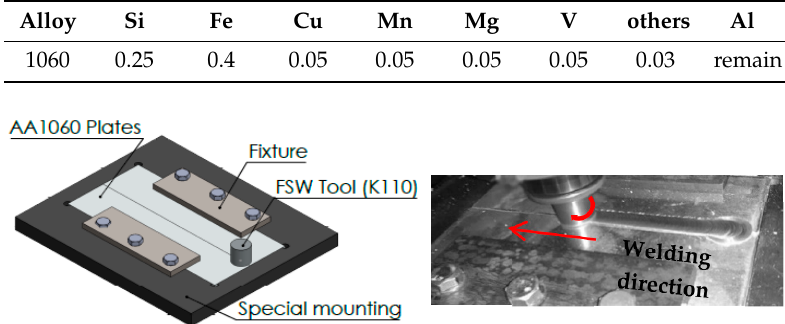
Figure 1. Experimental friction stir welding (FSW) process of AA1060 aluminum alloy.